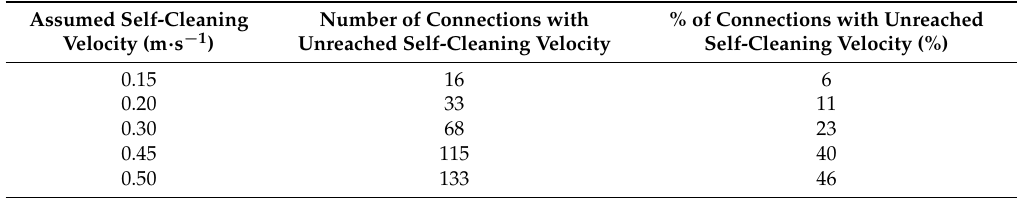
Table 7. Number and percent of conduits that did not reach self-cleaning velocity on the basis of simulation in the SWMM 5.1 program.